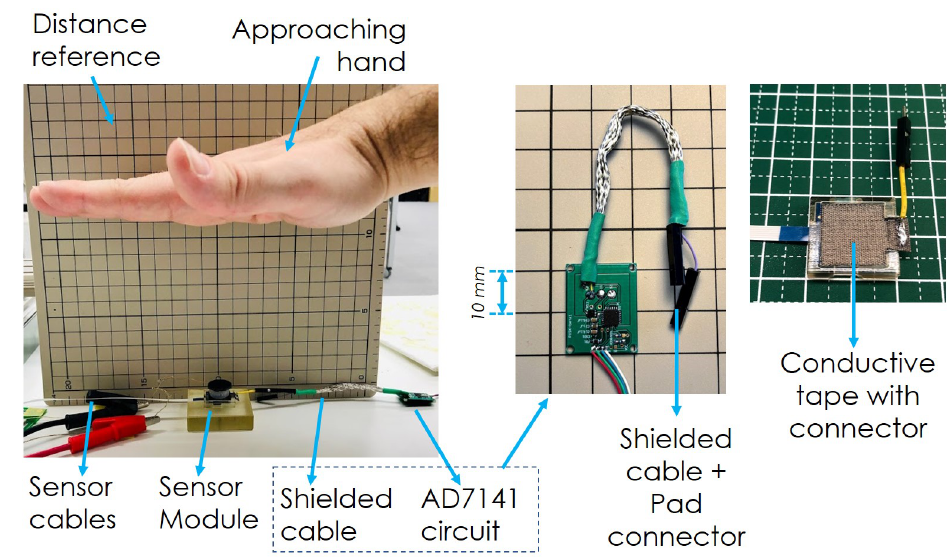
Figure 16. Test setup for “pre-touch” sensing. Hand approaches from the top, closing the distance to the sensor. Details on capacitive sensor PCB and conductive tape with connector from sensor.